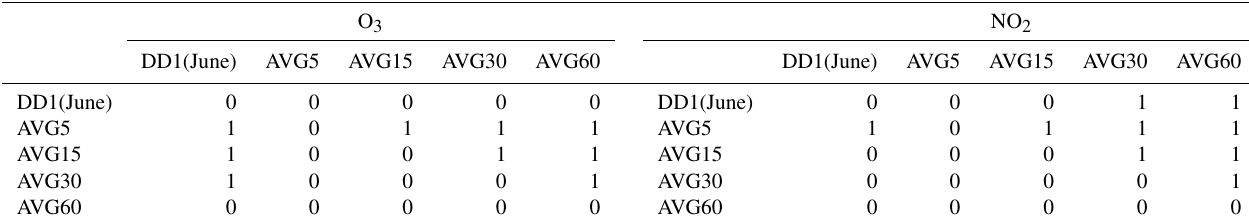
Table 5. Results of the pairwise Mann–Whitney U tests on the performance of KNN-D(ML) across temporally averaged versions of the DD1 dataset. We refer the reader to Sect. 5.1.1 for a discussion on how to interpret this table. The dataset names are abbreviated, e.g., DD1(June)- AVG5 is referred to as simply AVG5. Results are reported over a single split. AVG5 wins over any other level of averaging and clarifies that mild temporal averaging (e.g., over 5min windows) boosts calibration performance, whereas aggressive averaging, e.g., 60min averaging in AVG60, degrades performance. O 3 NO 2